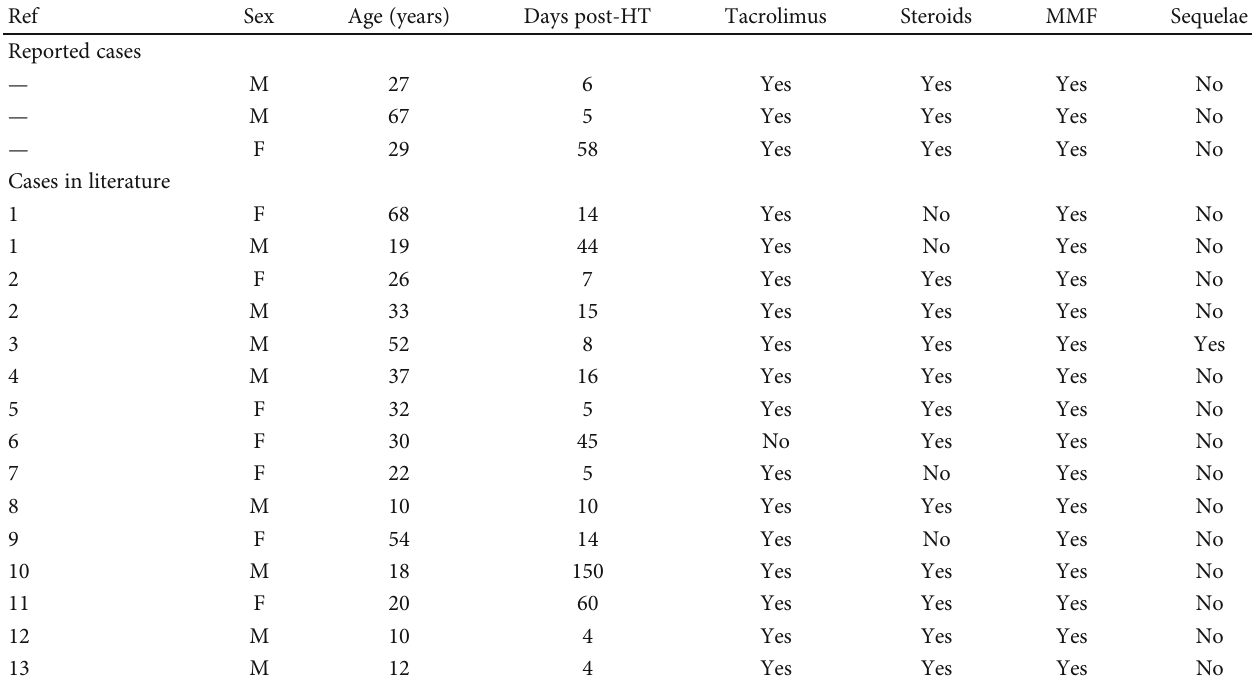
Table 2: Reported cases compared with reported cases in